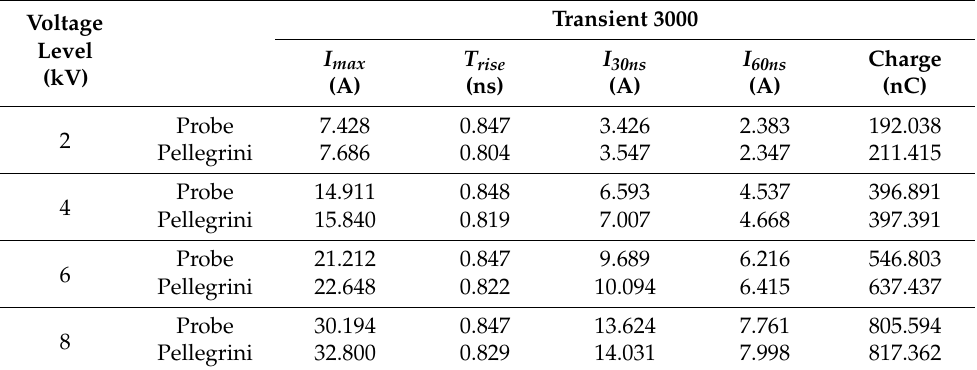
Table 6. Reconstructed and reference ESD current parameters the EMC Partner Transient 3000 ESD generator.